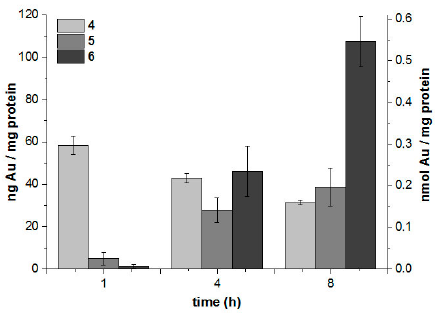
Figure 4. Cellular gold levels of MCF-7 cells exposed to 3.0 µM of 4 – 6 determined by HRCS-AAS.